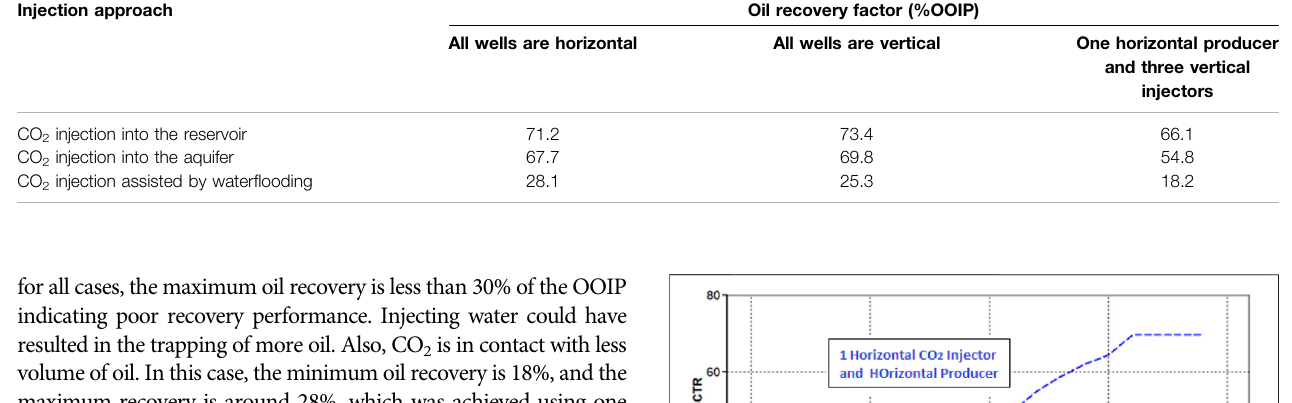
TABLE 1 | Oil recovery factors for all studied scenarios. Injection approach Oil recovery factor (%OOIP) All wells are